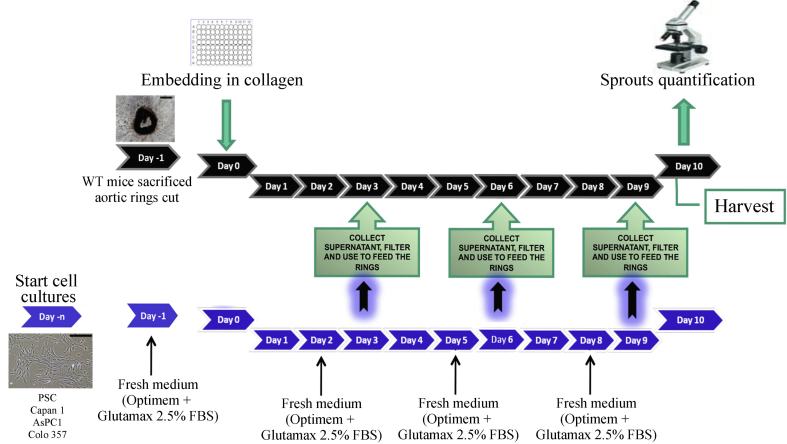
Supplementary Fig. 1Aortic rings angiogenesis assay. Schema of construction of aortic ring angiogenesis assays and feeding the aortic rings with conditioned media from cancer or stellate cells.